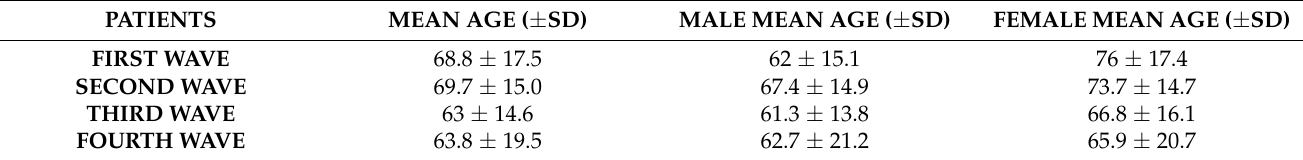
Table 2. Population demographics: population mean age and standard deviation (SD).